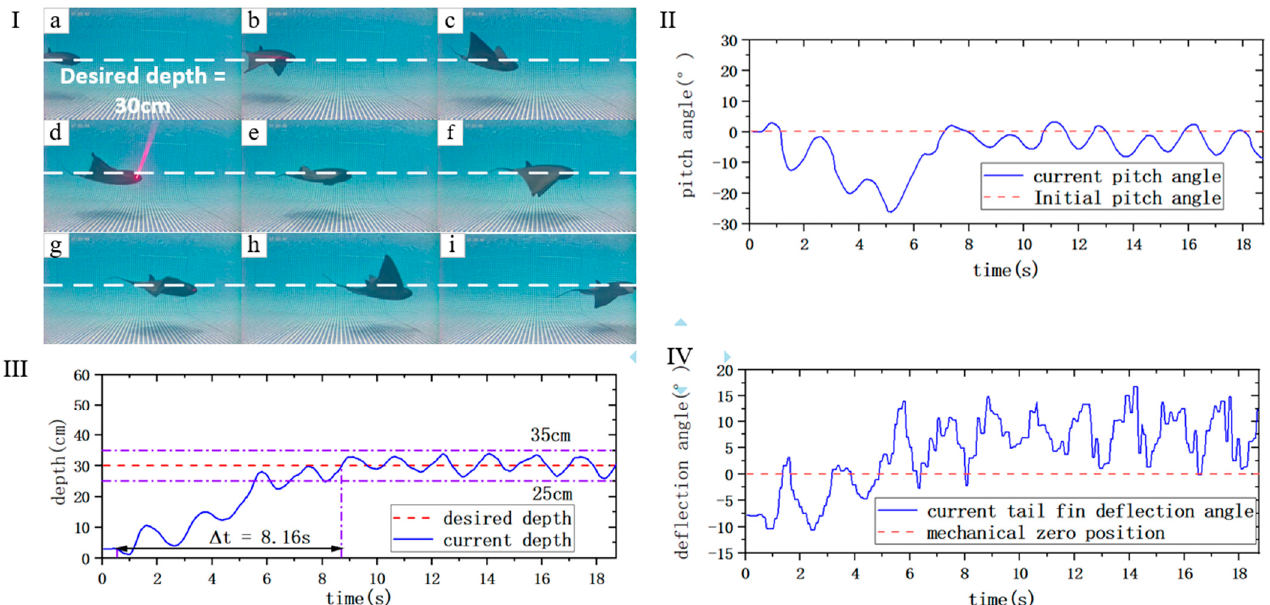
Figure 8. Frame diagram and data plot of the depth holding experiment. ( I ) Swimming frame diagram of the manta robot, where (a)–(i) represents the time order. ( II ) Pitch angle data graph of the manta robot. ( III ) Depth data graph of the manta robot. ( IV ) Data plot of tail fin deflection angle of the manta robot.